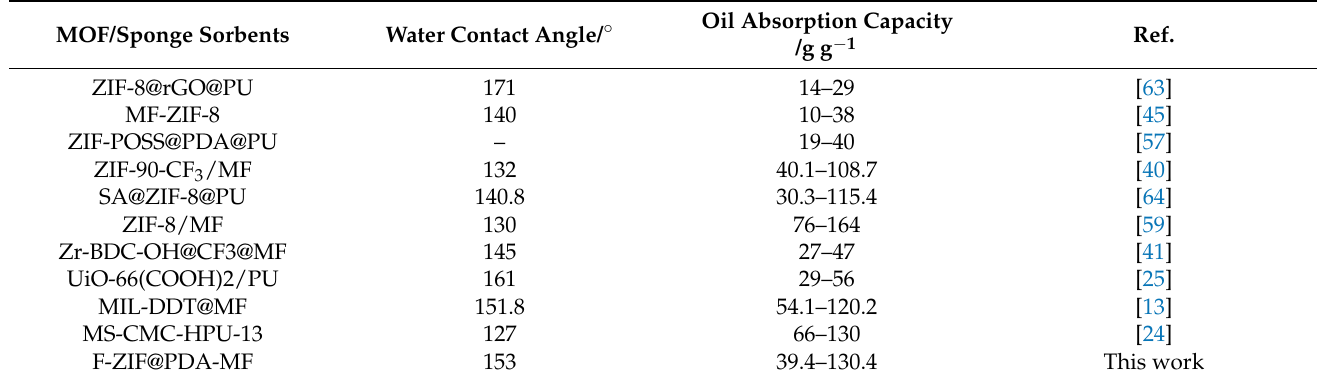
Table 1. Comparison of oil absorption capacities and water contact angles of various metal − organic frameworks (MOF)/sponge composite